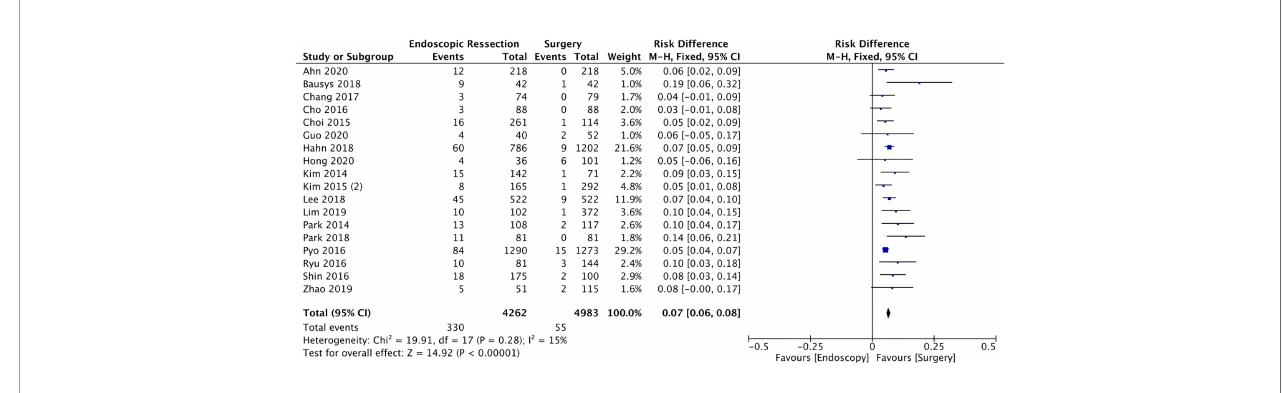
FIGURE 6 | Forest Plot Recurrence.